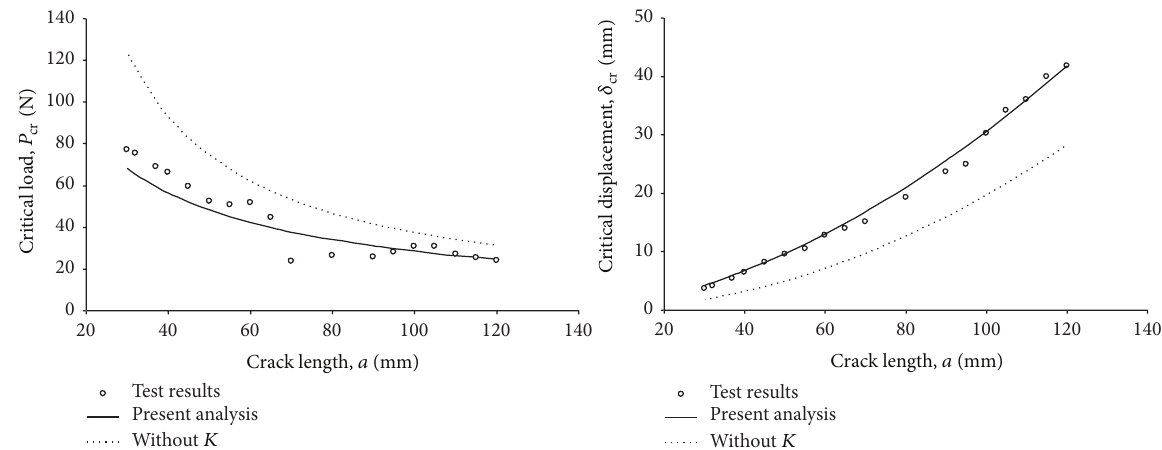
) and the corresponding displacement (𝛿 ) cr cr